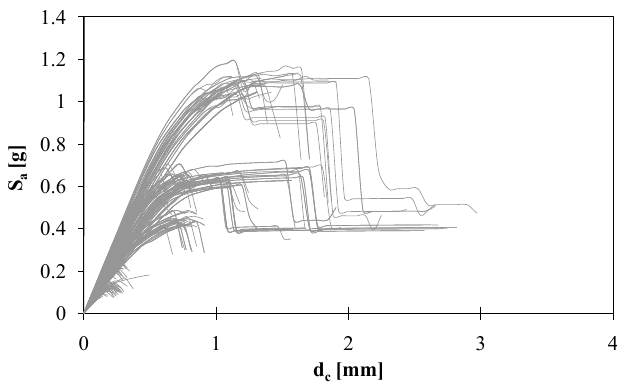
Figure 6. SPO curves related to all analysis